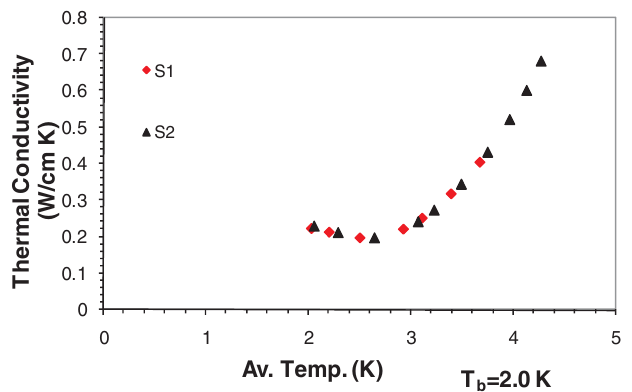
FIG. 7. (Color) The phonon peak is clearly absent in the thermal conductivity measurements of sample S1 in the tests carried out after 3% strains induced in the sample (test #3) as compared with its measurement in test #2.